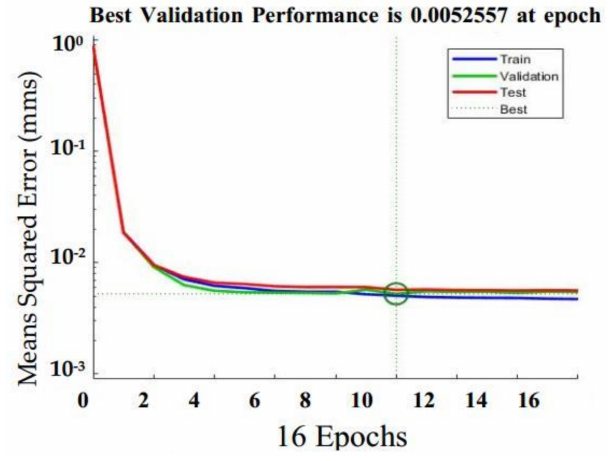
Figure 8. Mean square error